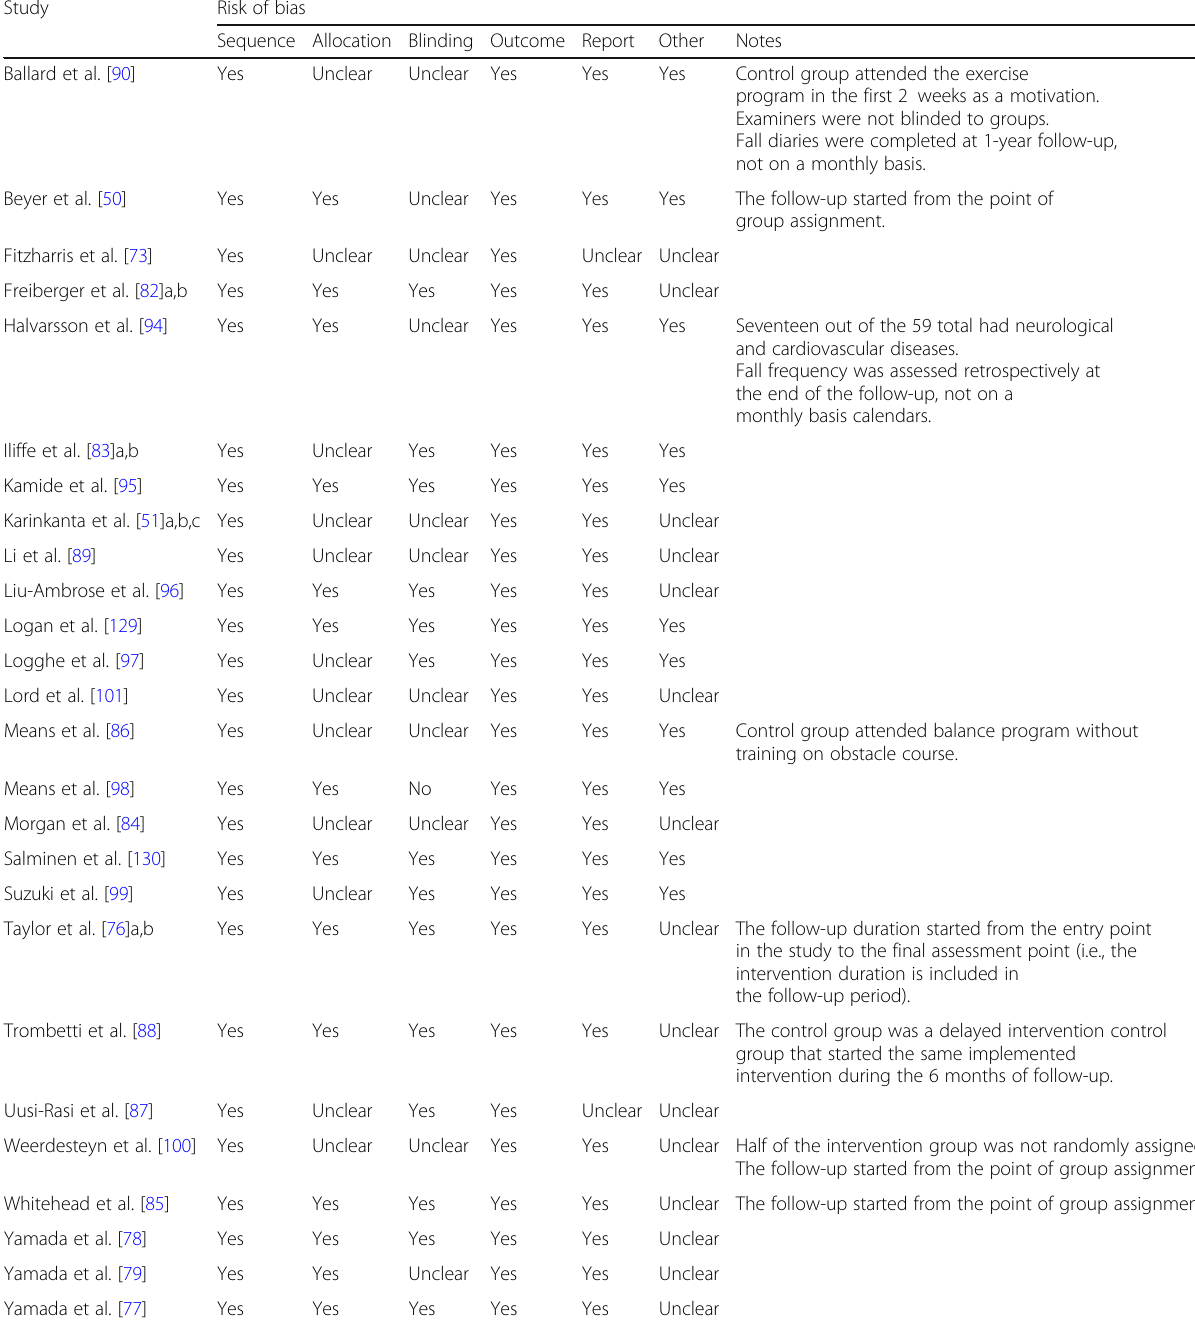
Table 4 Risk of bias assessment of the included studies according to Cochrane risk of bias assessment tool